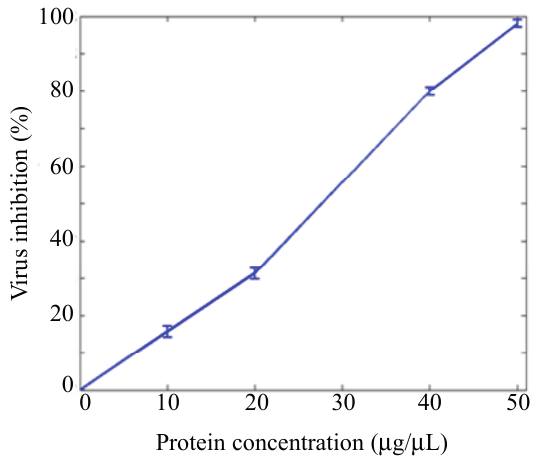
Figure 6. Virus blocking assay of hybrid HBcAg VLPs. The error bar denotes the standard deviation of three replicate